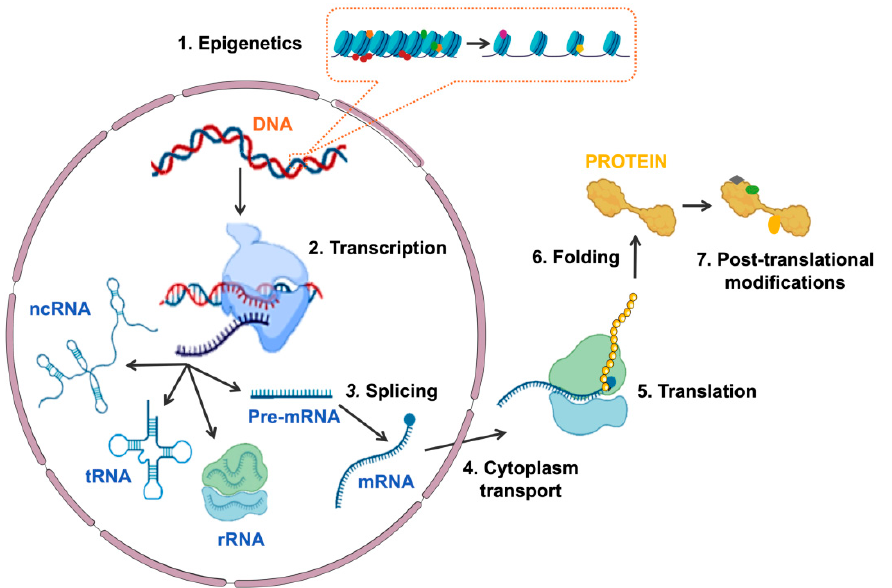
Figure 1. Schematic representation of the different mechanisms involved in regulating gene expres- sion. The sequential regulatory events are: (1) epigenetics modifications at chromatin, (2) transcription of DNA to RNA, (3) splicing of pre-mRNA, (4) mRNA transport to cytoplasm, (5) translation of mRNA to protein, (6) protein folding and (7) protein post-translational modifications. Abbrevia- tions: ncRNA, non-coding RNA; tRNA, transferring RNA; rRNA, ribosomal RNA; Pre-mRNA, pre-messenger RNA; mRNA, messenger RNA.